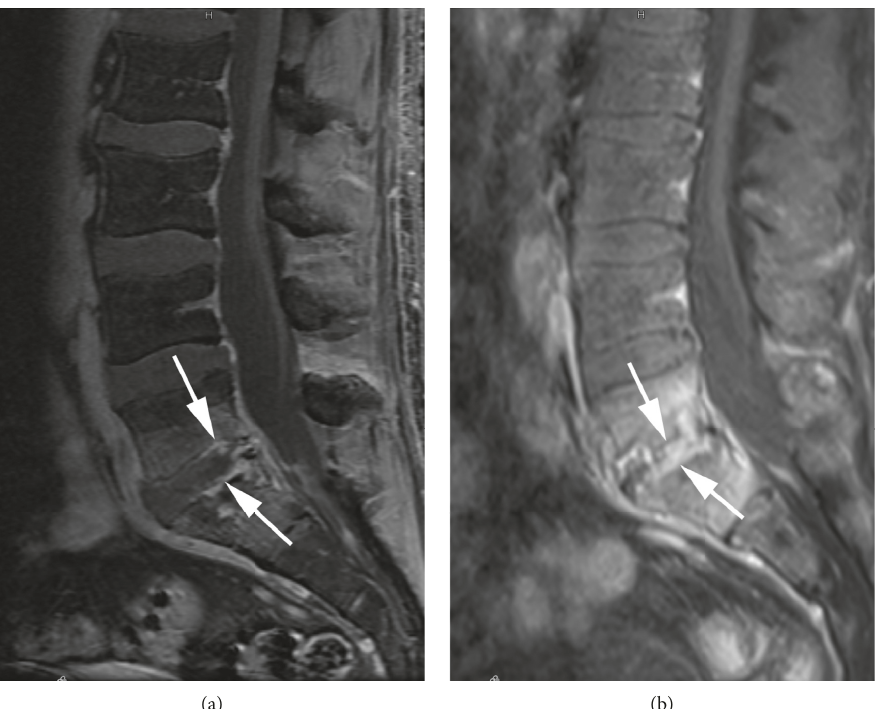
Figure 1: T1-weighted fat-suppressed lumbar spine MR images after contrast agent administration. (a) Initial MRI demonstrating spondylodiscitis L5/S1 with subtle contrast agent enhancement of both intervertebral disk L5/S1 and adjacent subchondral bone (arrows). (b) A follow-up MRI at 4 months showing progressive spondylodiscitis (arrows) without abscess